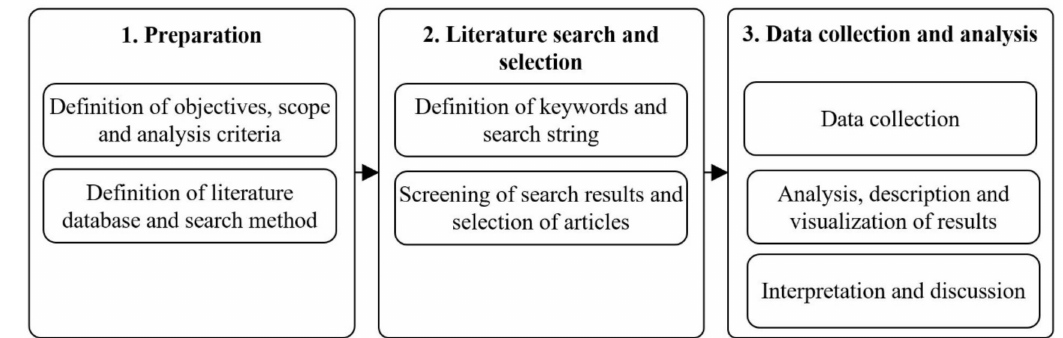
Figure 1. Review procedure. The literature review process is divided into three main